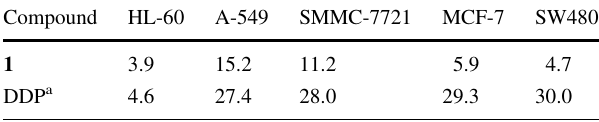
Table 2 Cytotoxicities of 1 against five human cancer cell lines (IC 50 l